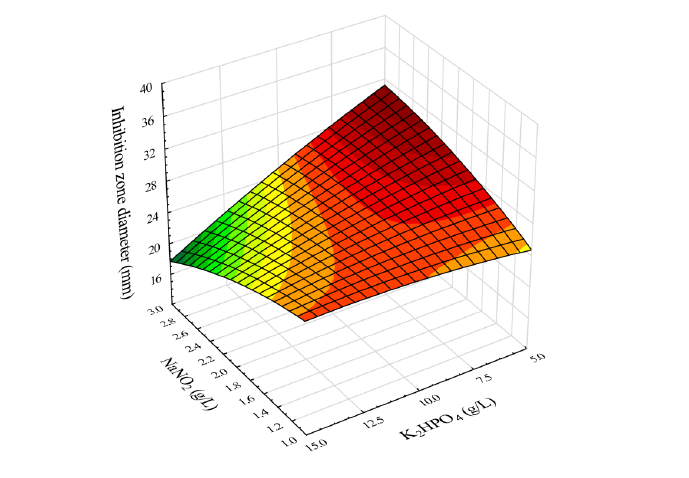
FIGURE 5 - The effects of NaNO content of 35 g/L.